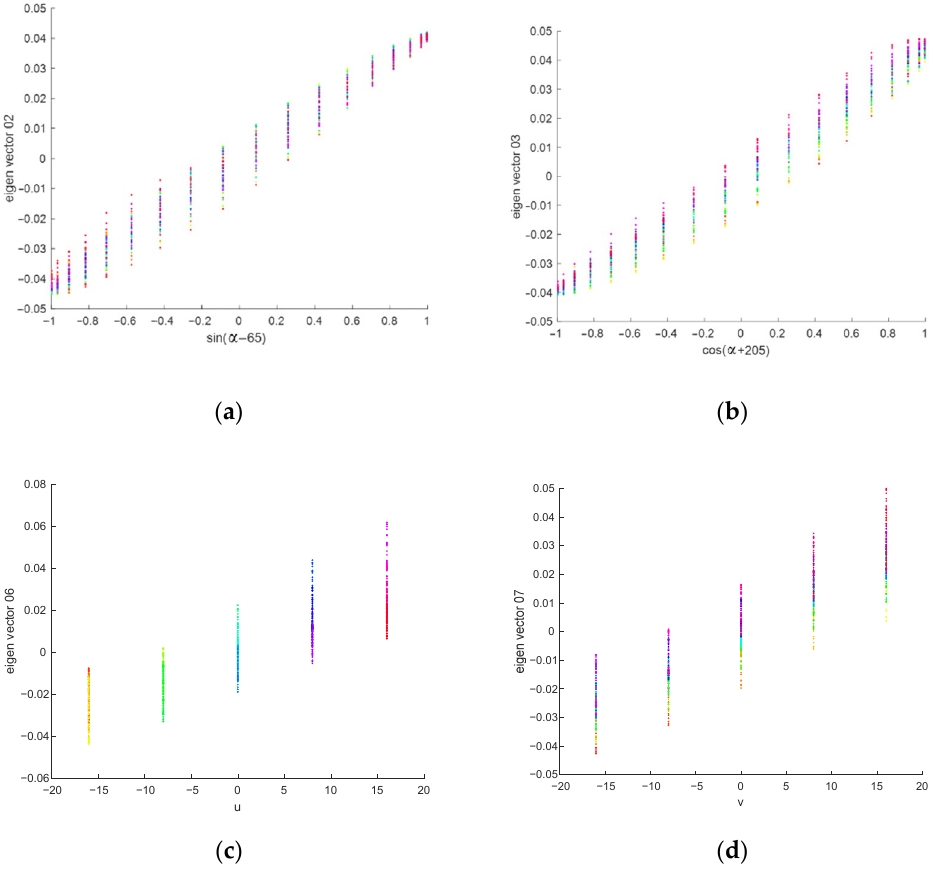
Figure 6. Correlation of eigenvectors with the robot coordinates and rotation angle: ( a ) correlation of the second eigenvector with sin( α – 65) of rotation angle α ; ( b ) correlation of the third eigenvector with cos( α + 205) = sin( α – 65)ofrotationangle α ; ( c ) correlation of the sixth eigenvector with robot coordinate u ; ( d ) correlation of the seventh eigenvector with robot coordinate v .